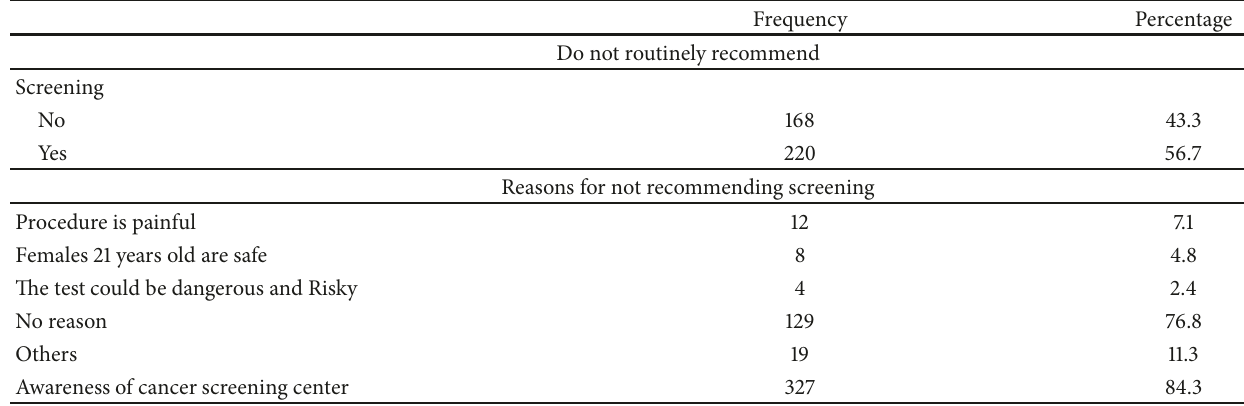
Table 4: Nurses’ attitude towards recommendation for cervical cancer screening.